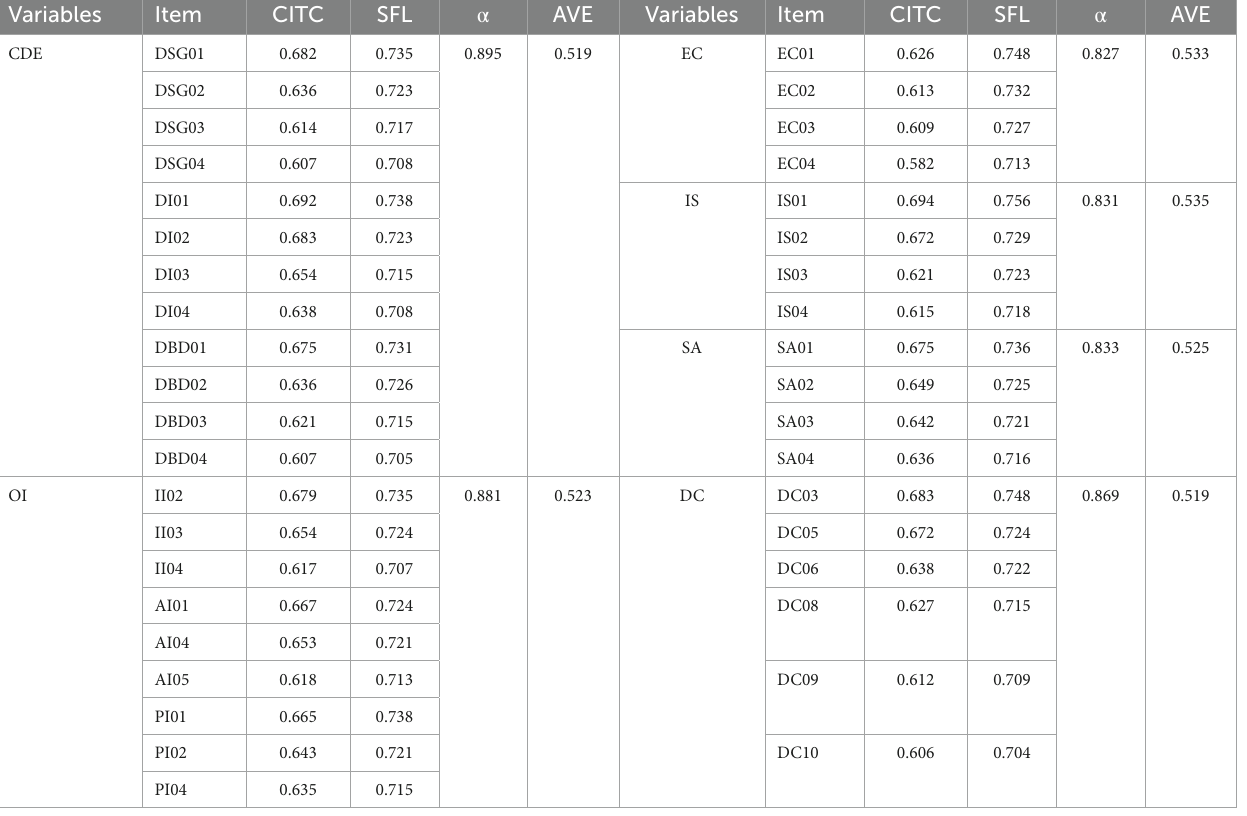
TABLE 2 Results of reliability and validity.